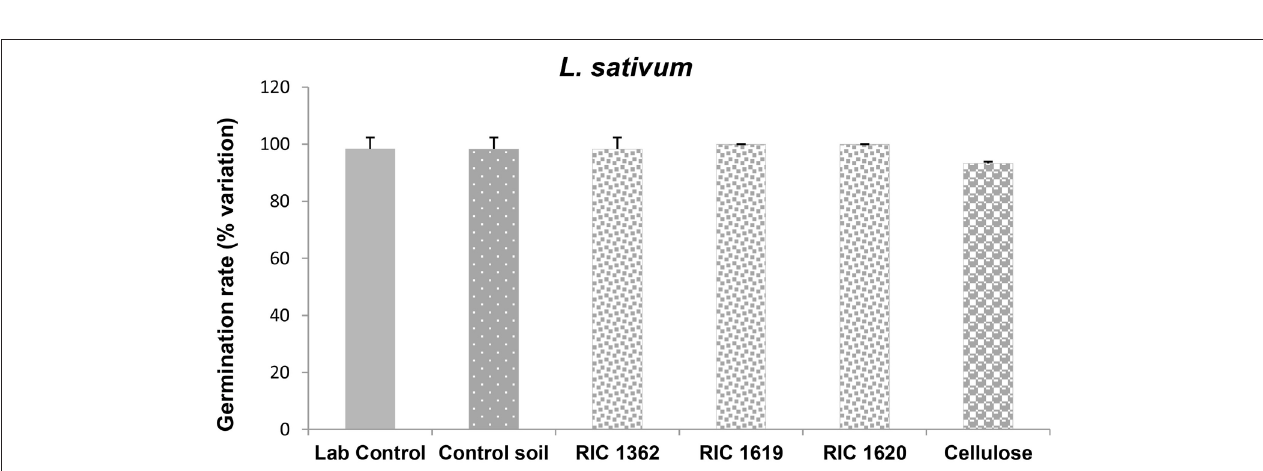
FIGURE 3 | Germination of S. saccharatum after exposure to the soil samples. Data are expressed as % variation and represent the mean ± SD of at least five replicates. *Indicates statistically significant differences with respect to lab control values ( p < 0.05 Mann–Whitney U -test). RIC 1362, RIC 1619, RIC 1620, Mater-Bi soils; Cellulose, soil containing cellulose reference material.